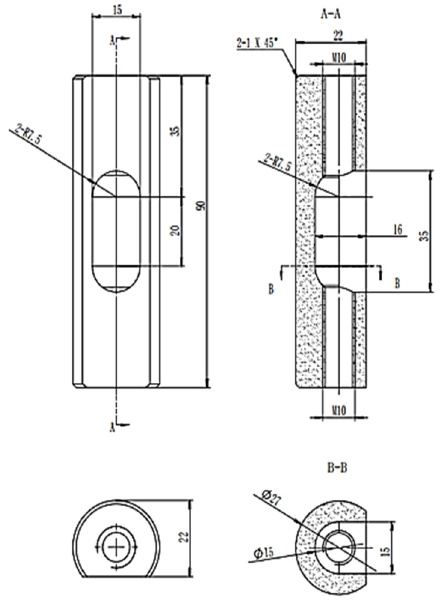
Figure 2. Crucible dimensions of the melt smelting device under pulse current.